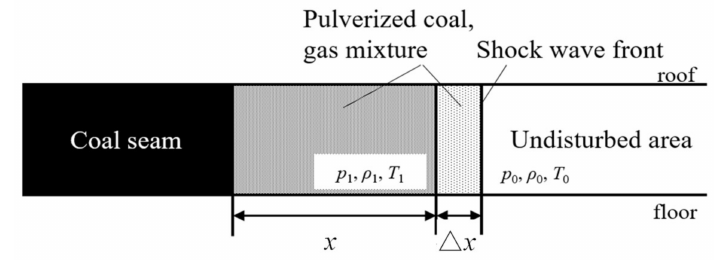
Figure 10. Shock wave formation model of coal and gas